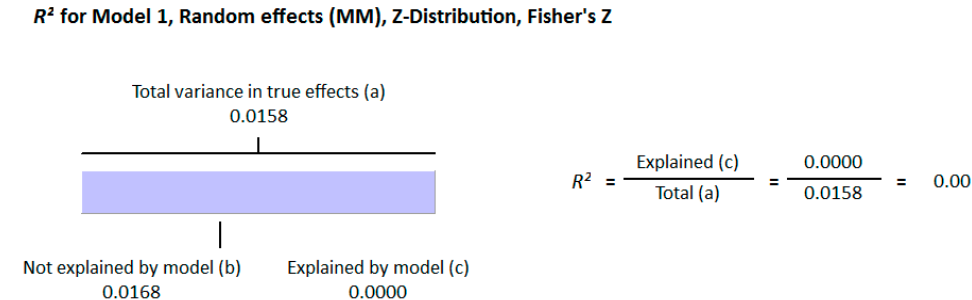
Figure 3. Meta-regression analysis for non-diabetic subject studies. Latitude R 2 shows the effect of the moderator on the heterogeneity of correlation. ( a ) total variance in true effects; ( b ) not explained by model; ( c ) explained by model.